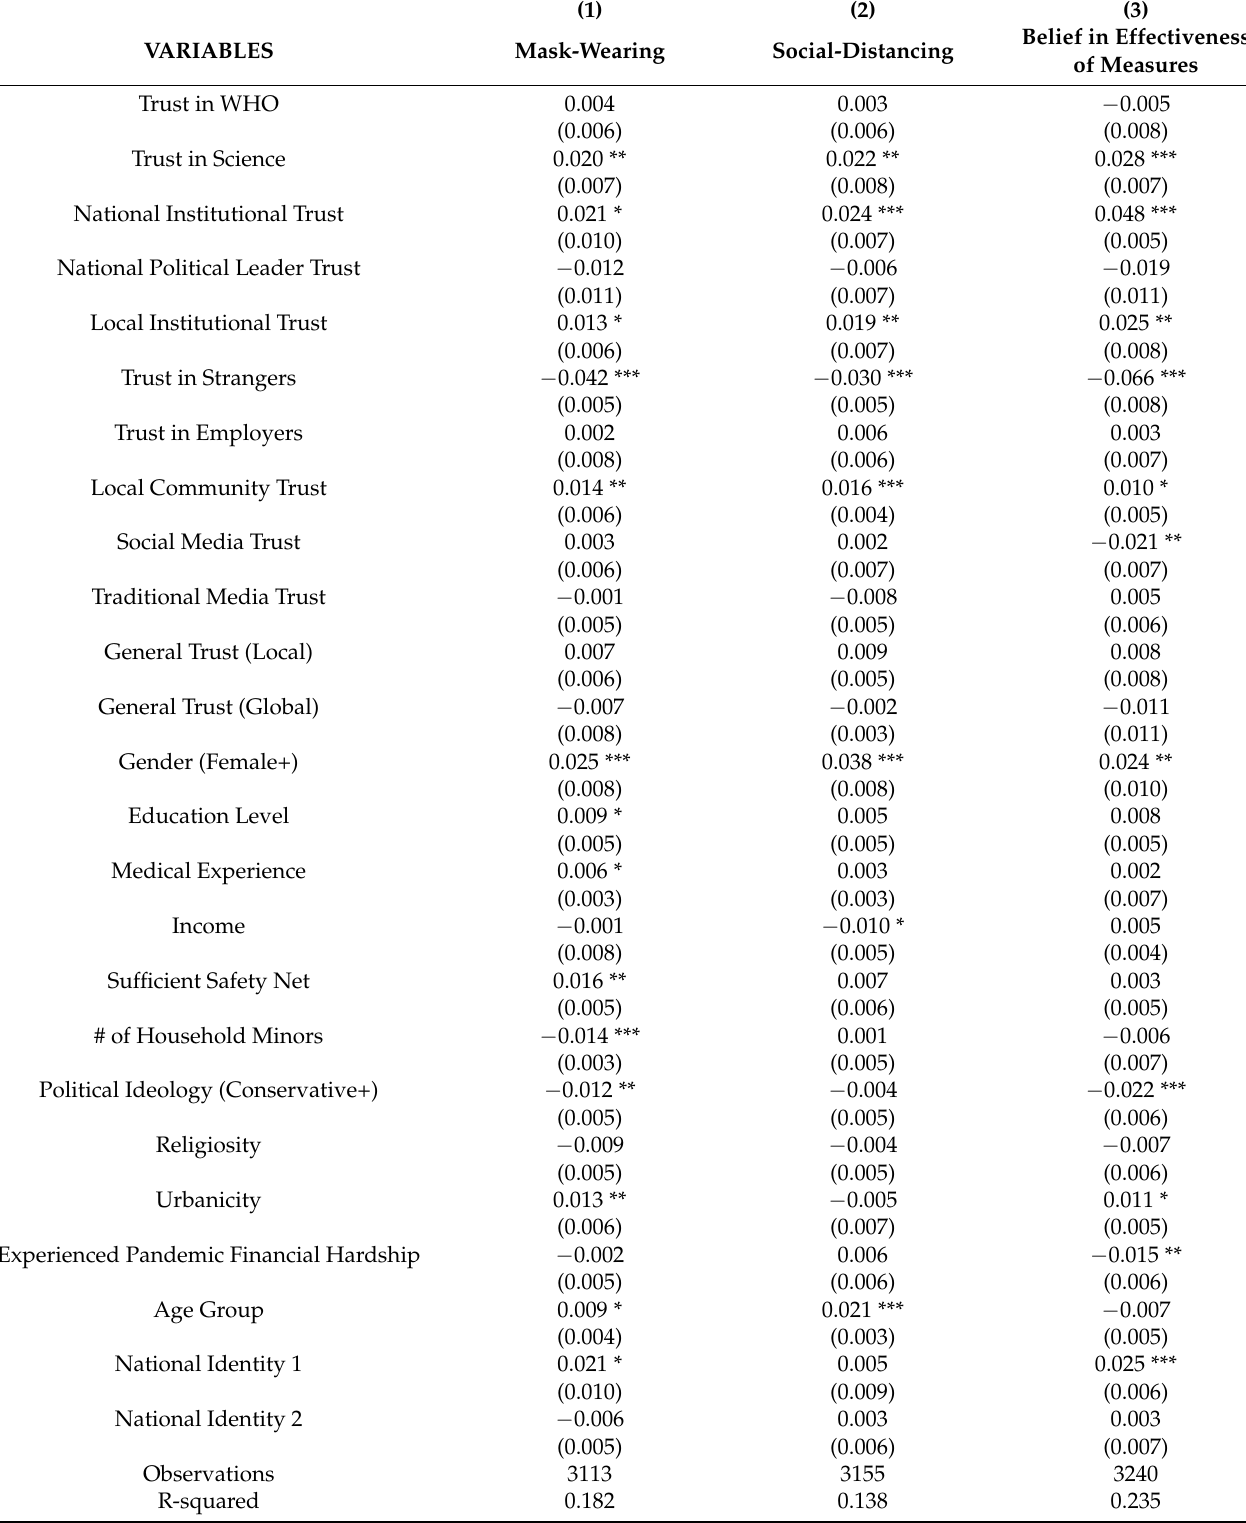
Table 1. Linear regression summary of the impact of trust variables on public health measure compliance (masks and social distancing) and belief in effectiveness of health measures